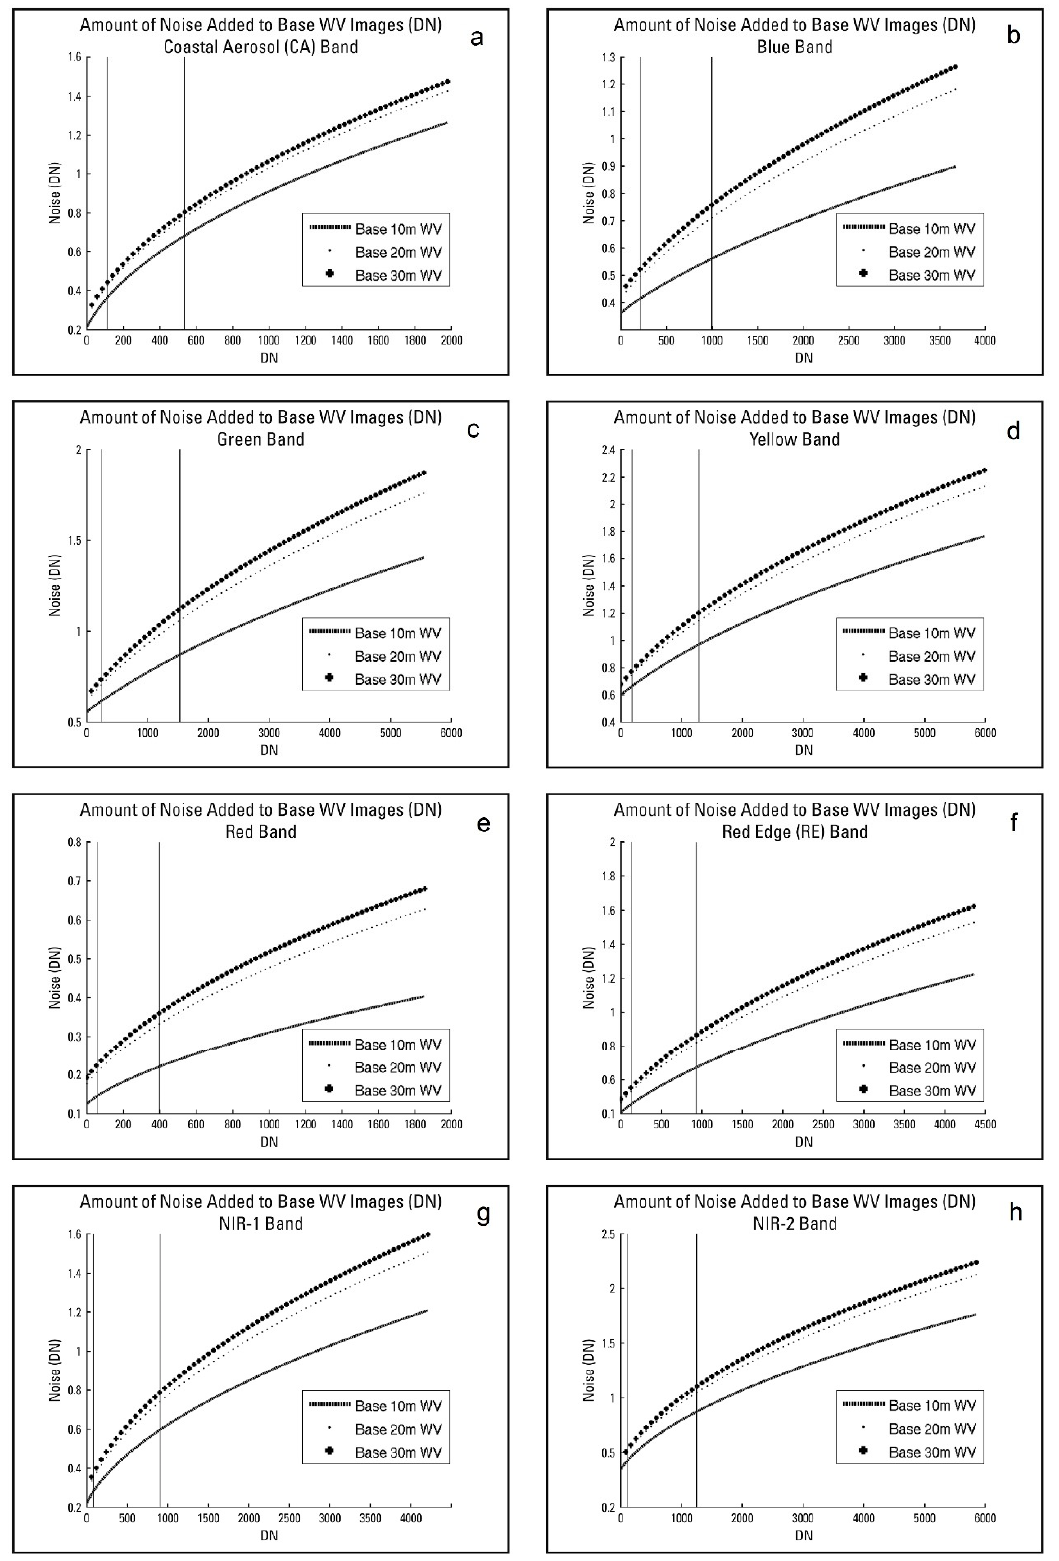
Figure 3. Actual noise added to each WV3 spectral band: coastal ( a ), blue ( b ), green ( c ), yellow ( d ), red ( e ), red edge ( f ), near-infrared 1 (NIR1) ( g ), and near-infrared 2 (NIR2) ( h ). The black vertical lines are the defined L-typical radiance for the Landsat OLI, converted to Digital Number (DN).